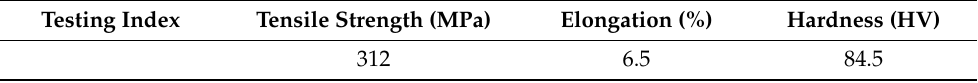
Table 5. Verification test